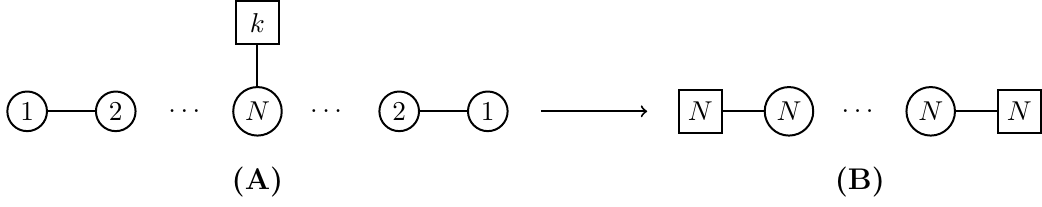
Figure 3. The mirror pair we will use to derive the dual of adjoint U( N ) SQCD. There are k (cid:0) 1 U( N ) gauge groups in the linear quiver on the right. The construction involves applying the sequential con(cid:12)nement procedure to the two T (SU( N )) tails on the left.